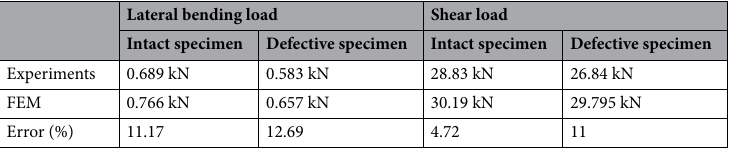
Table 6. Results of finite element and experimental